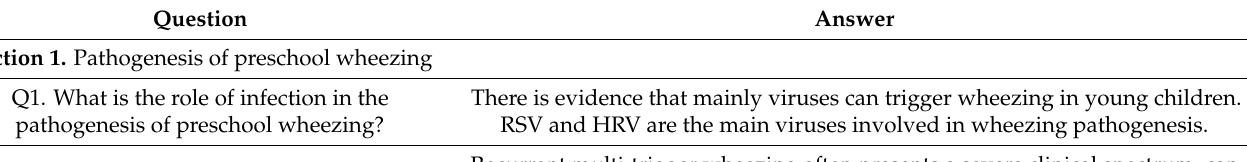
Table 1. Statements on risk factors affecting development and persistence of preschool